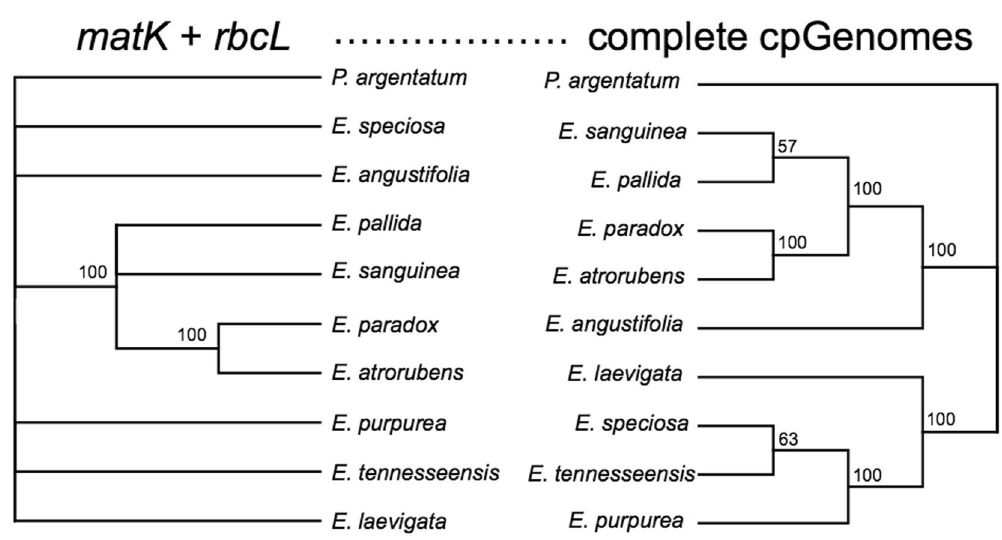
Figure 3. ML trees reconstructed using matK + rbcL (left) and using chloroplast genomes (right) Numbers are bootstrap values, branches with bootstrap values < 50% are collapsed. These two phylogenies show the power of chloroplast genomes for delimitation of Echinacea species when compared with core DNA